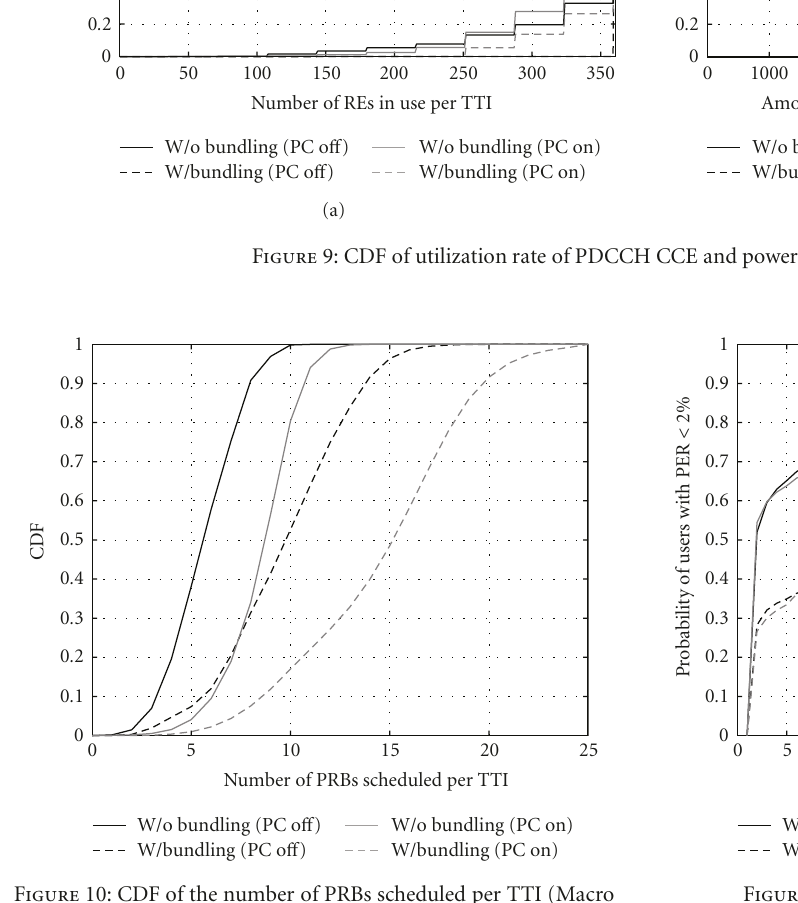
Figure 11: CDF of packet delay (Macro Case